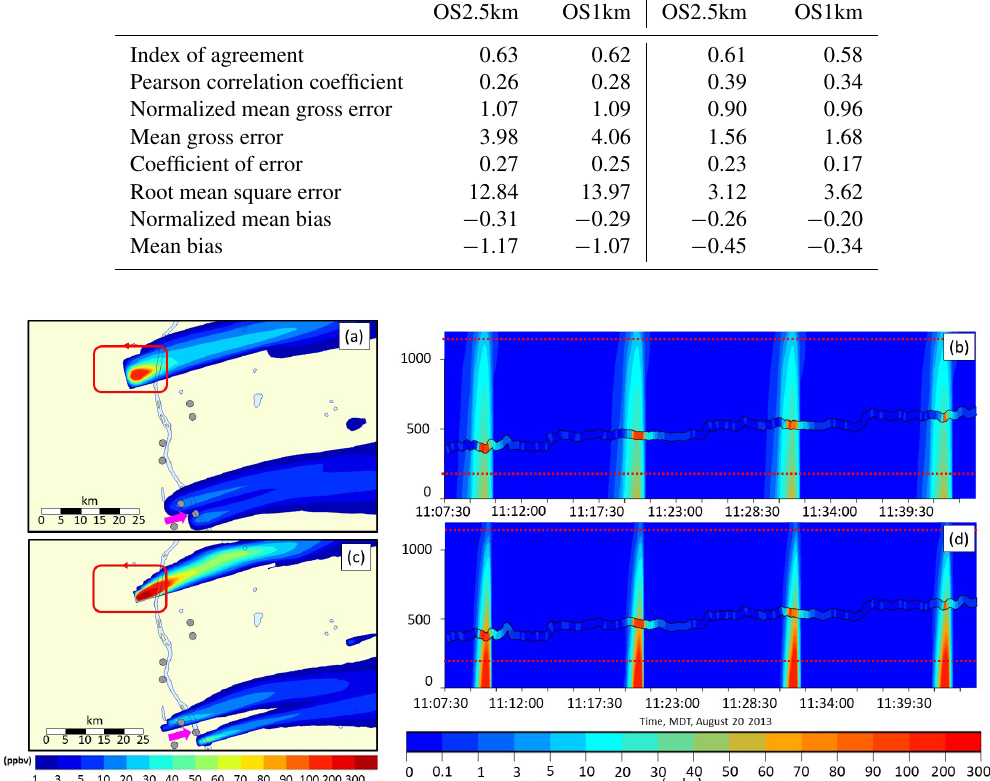
Figure 8. Comparison between OS2.5km (a, b) and OS1km (c, d) simulations for SO 2 relative to aircraft observations (ppbv). (a, c) Simu- lated surface concentrations of SO 2 , with the flight track shown as a red line. Grey circles: surface monitoring station locations; pink arrow indicates a station located inside a plume at 2.5km resolution (a) , and outside the plume at 1km resolution (c) . (b, d) Portion of the sim- ulated concentration profiles along the flight path as a function of time. Successive intersections of the flight path with the plume appear as background colour contours; observed SO 2 aboard the aircraft is shown between the two black lines. Vertical axis is elevation above the ground; the aircraft elevation is increasing with successive passes around the facility. Dotted lines show the upper and lower vertical extent of the observed plume; note that for both model simulations, the plume erroneously fumigates the surface.